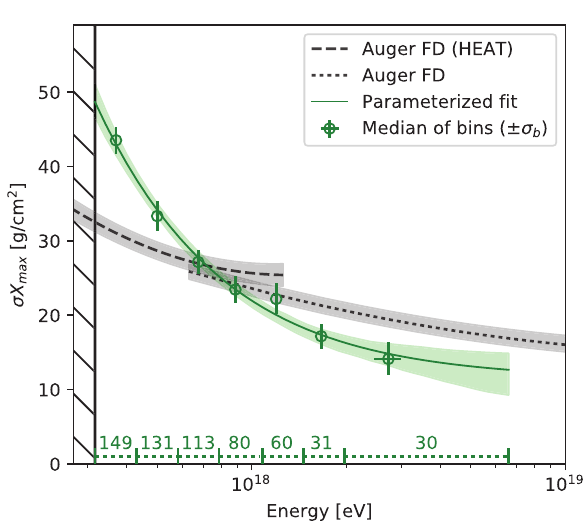
Figure 1. Median resolution of the AERA X max reconstruction (green points) and fitted function (green line, Eq. 1). Inset at the bottom are the sizes of the energy bins and the number of events per bin. For comparison also the X max resolution for the Auger FD is shown (black lines).